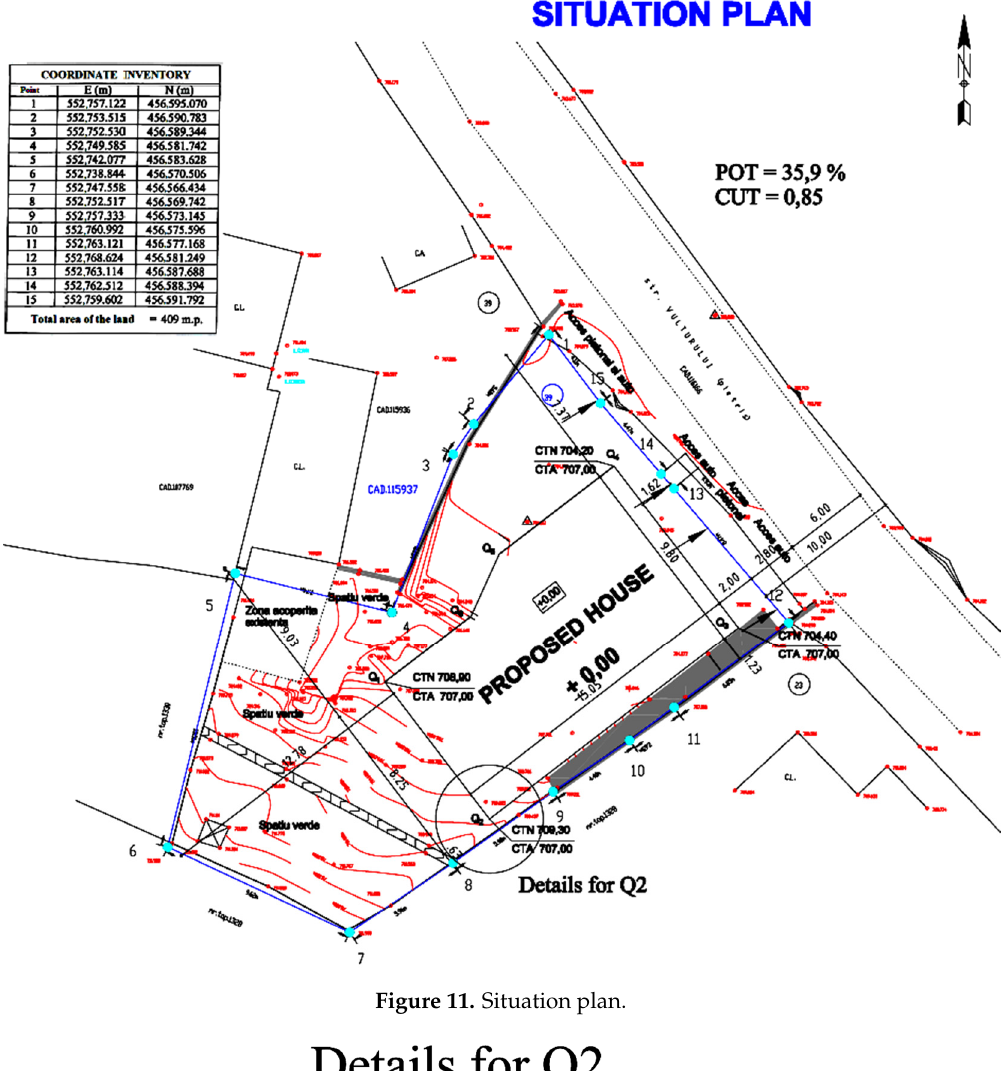
Figure 11. Situation plan. Table 1. The x and y coordinates of the Q points.